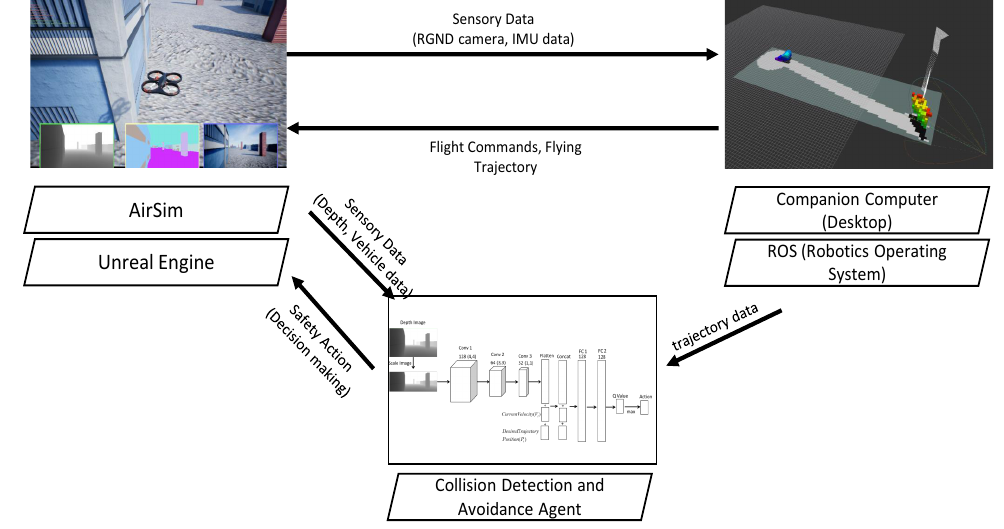
Figure 10. Architecture of the SITL